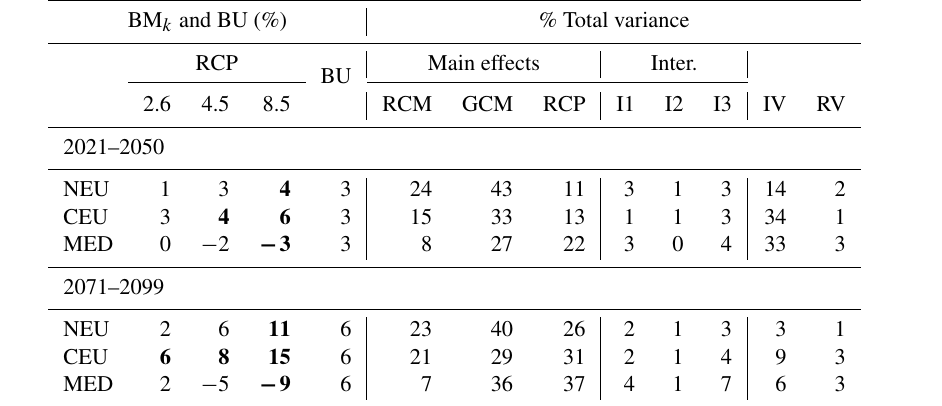
Table 3. Same as Table 2 for relative changes in total precipitation in winter